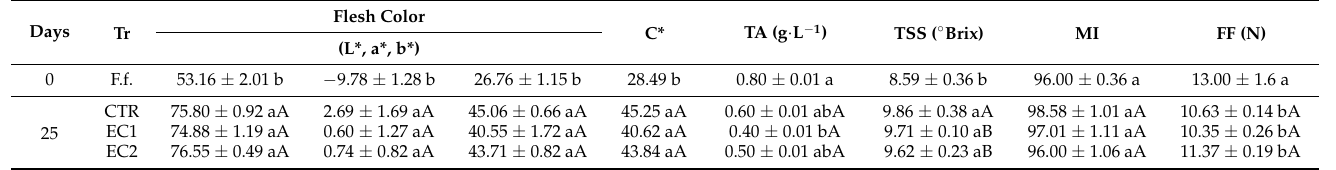
Table 3. Physicochemical characteristics of fresh C. papaya fruit (F.f.) at d 0 and on last day of storage (d25). Treatments (Tr): CTR = control; EC1 = A. arborescens with EOs of Origanum vulgare subsp. viridulum ; EC2 = hydrolate- Lightness (L*), redness (a*), yellowness (b*), chroma (C*); titratable acidity (TA), total soluble solids (TSSs); maturity index (MI), firmness (FF). Values means ± S.E. The processed results are respectively mean ± standard error (S.E.) of three replicates. Values with the same letter are not significantly different at p ≤ 0.05 (Tukey’s test). Lowercase letters in the apex are used to indicate differences in time for the same treatment; uppercase letters indicate differences between treatments at the same time of